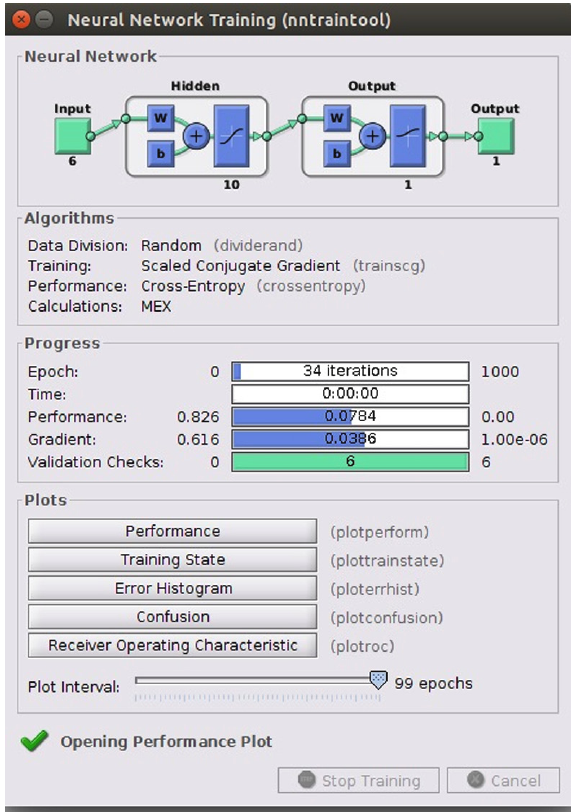
Fig. 6. Training progress of the neural network